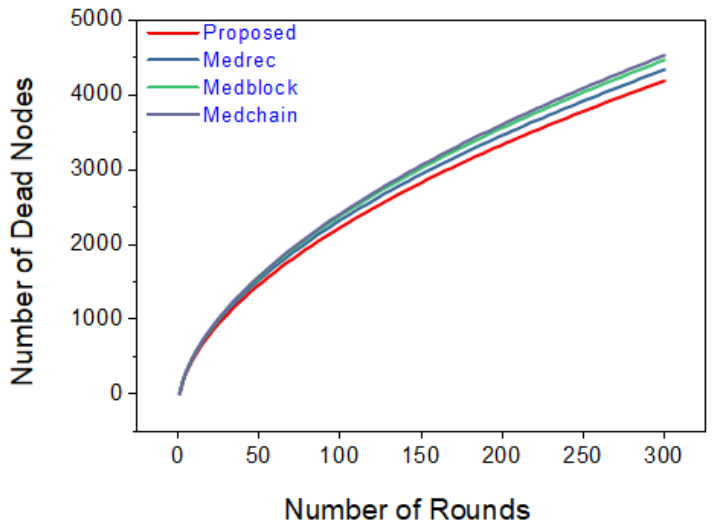
Figure 22. Comparative analysis of the proposed flexible policies for the cross-domain case and the benchmark models [49–51].